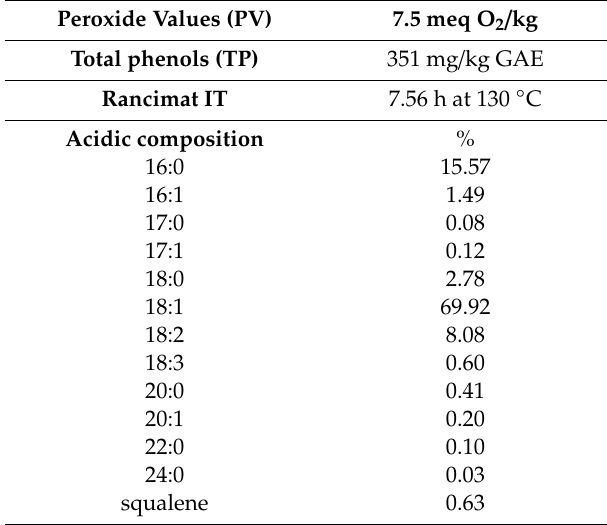
Table 1. Characterization of the olive oil used for preparing